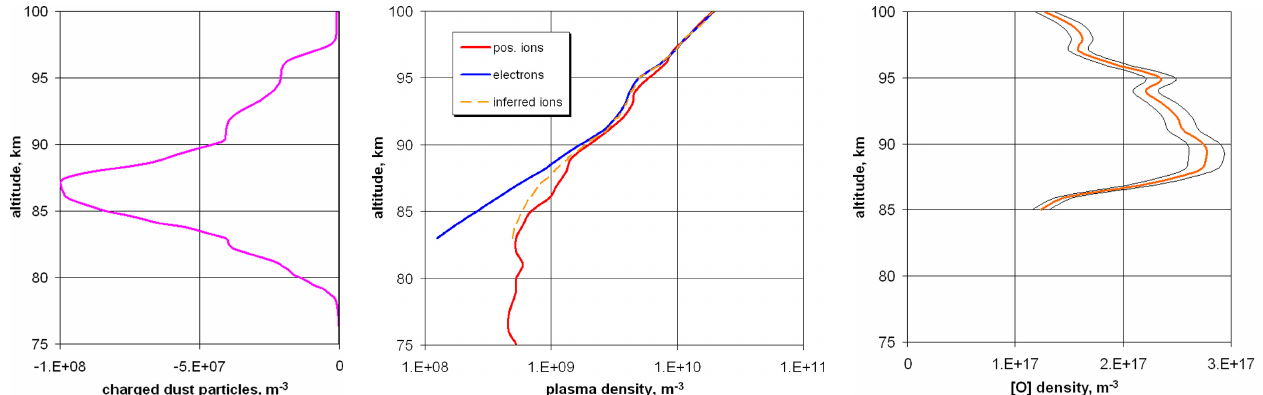
Fig. 3. Negative charged particles (left panel), plasma densities (electrons, ions and inferred ions, centre) and atomic oxygen (right panel) with error limits in the retrieval (flight HotPay-2). Table 1. List of flights with particle detectors together with electron and ion density measurements.